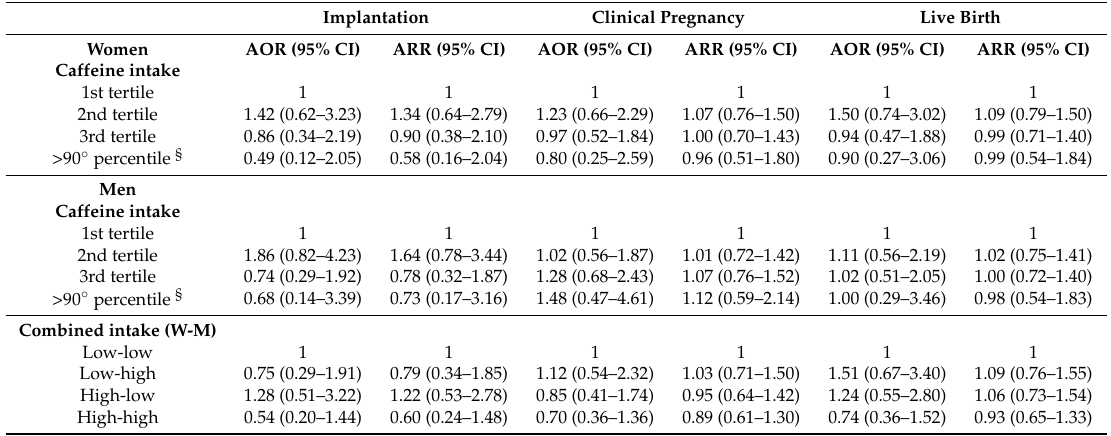
Table 1. Odds ratios and rate ratios for the three